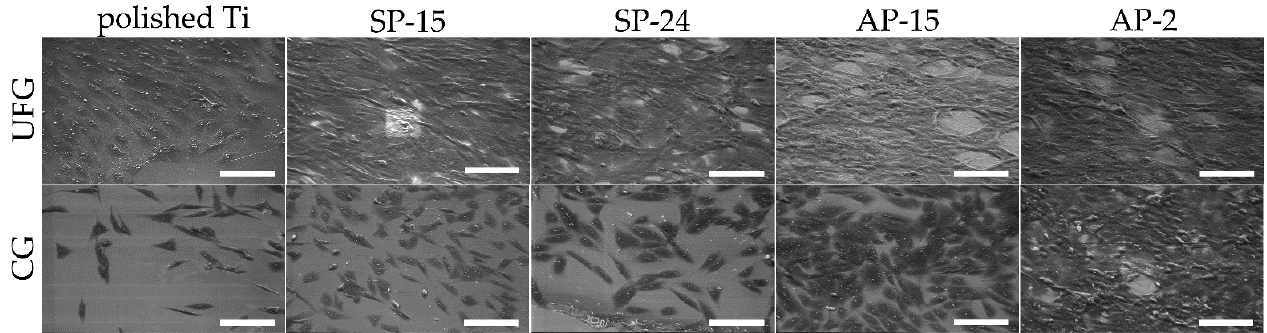
Figure 4. The morphology of MG ‐ 63 cells co ‐ incubated after 24 h of cultivation. Scale bar—100 μ m.